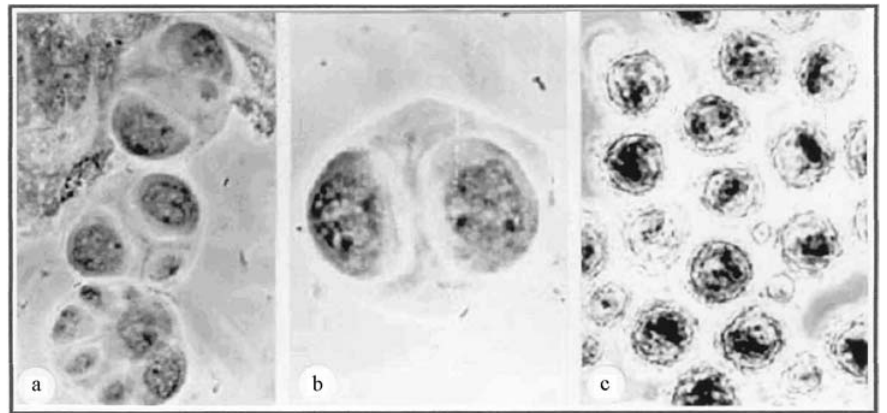
Figure 4 - Microsporogenesis and pollen in Eupatorium laevigatum . Key: a = two microspore dyads each with a supernumerary microspore and a polyad of microspores (580x); b = microspore dyad (950x); c = nonviable pollen grains